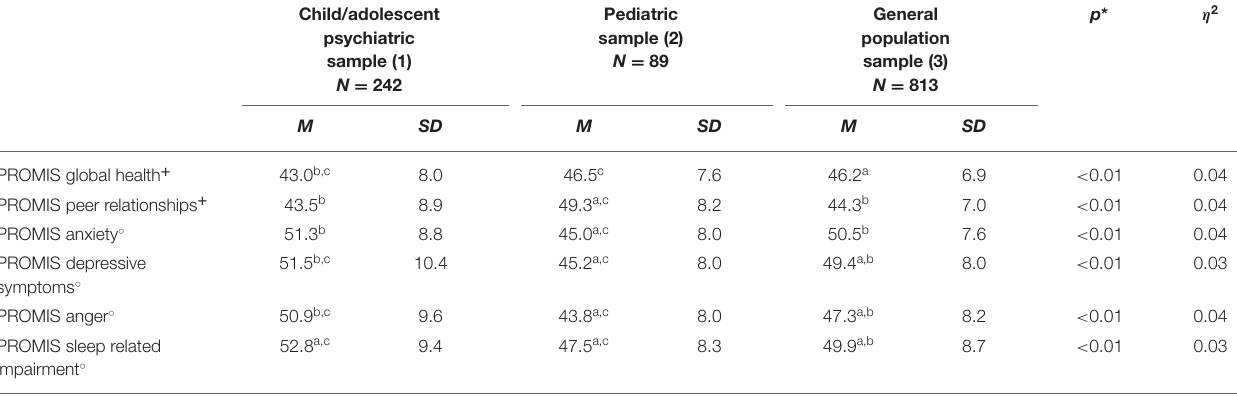
TABLE 2 | Mean PROMIS T-scores in the different samples during COVID-19, corrected by age, sex, and parental country of